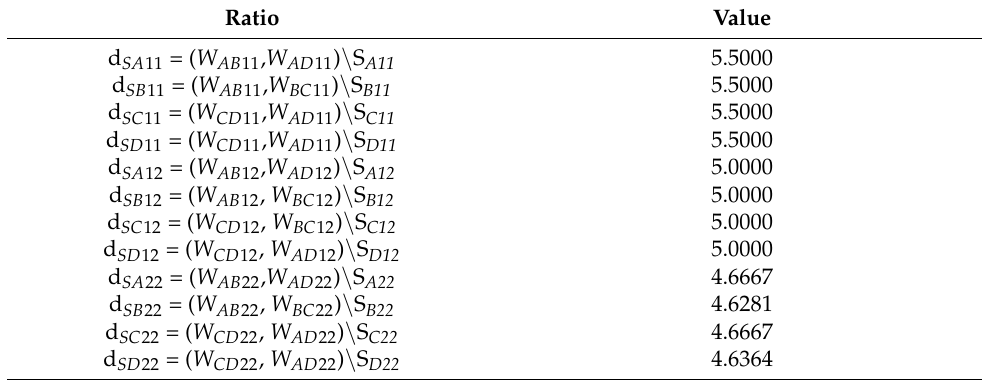
Table A2. The initial data defining the positions of the points S Aij , S Bij , S Cij , S Dij for i , j = 1,